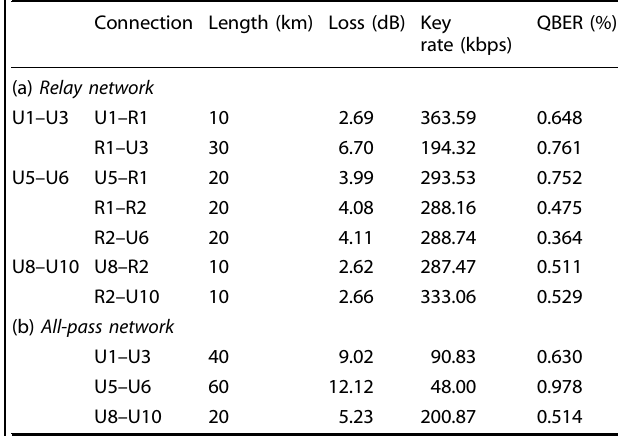
Table 2. Comparison of key rates and QBERs between the relay network and all-pass network.